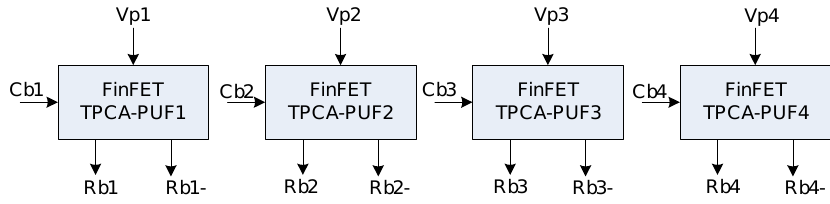
Figure 5. Proposed 4-bits FinFET TPCA-PUF architecture .